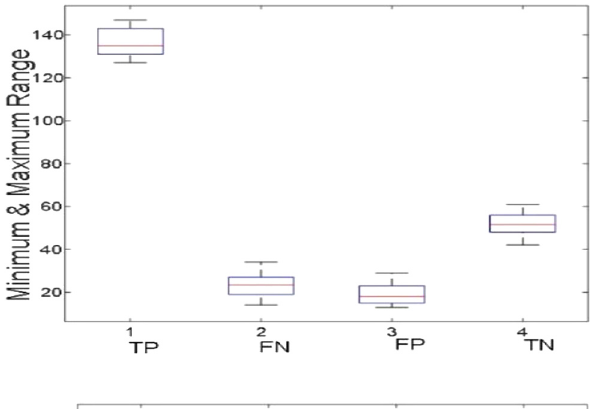
Figure 14: Boxplot